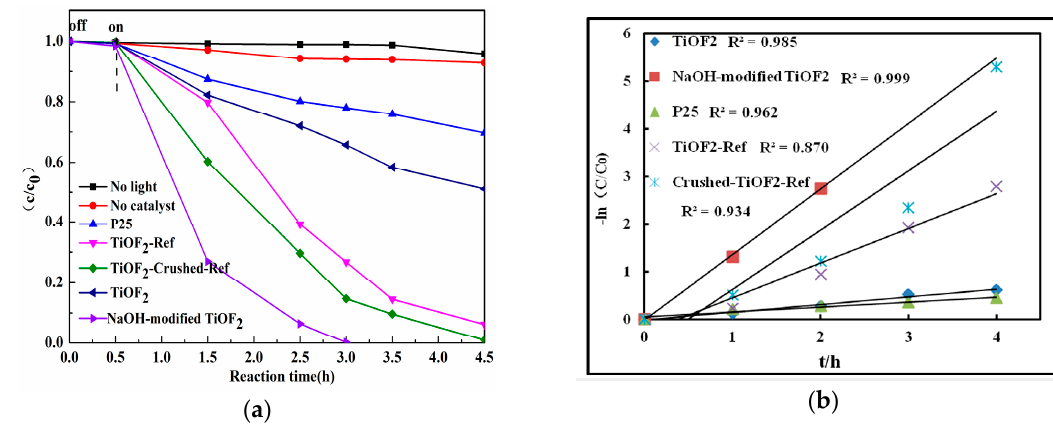
Figure 5. Catalytic activity of RhB under visible light: ( a ) concentration dependent on time and ( b ) kinetic fit for the degradation of RhB.